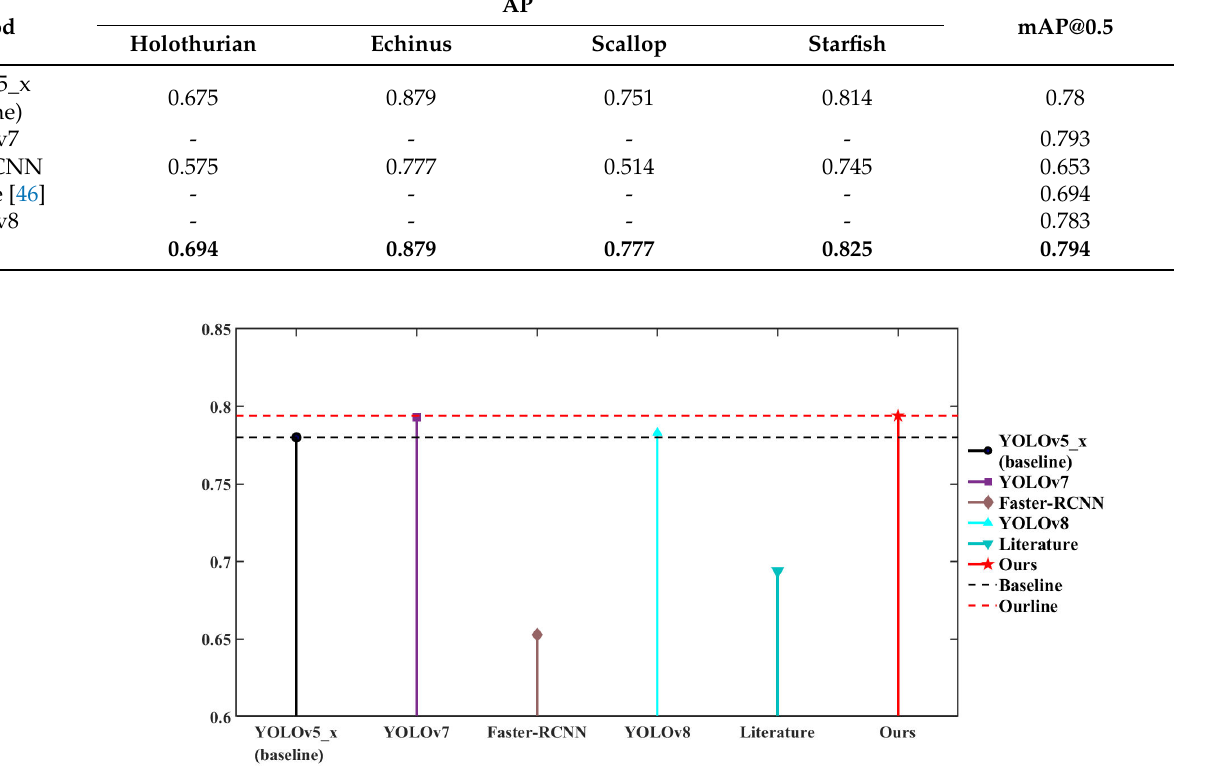
Figure 19. Visualization of comparative experiments based on URPC2020 dataset. The parameters and flops of our improved YOLOv5x are 208.0 M and 432.8 G, re- spectively. The original YOLOv5x had parameters and flops of 86.7 M and 205.7 G, while YOLOv8x had parameters and flops of 68.2 M and 257.8 G. Despite having a larger number of parameters than the others, our model achieved a higher accuracy than